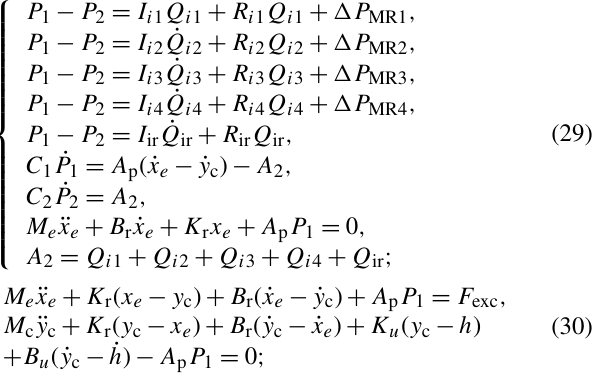
lable multi-channel semi-active MR fluid mount is shown in Fig. 16. Equations (29) and (30) for the 1 / 4 vehicle model of controlled multi-channel semi-active MR fluid mount are given.